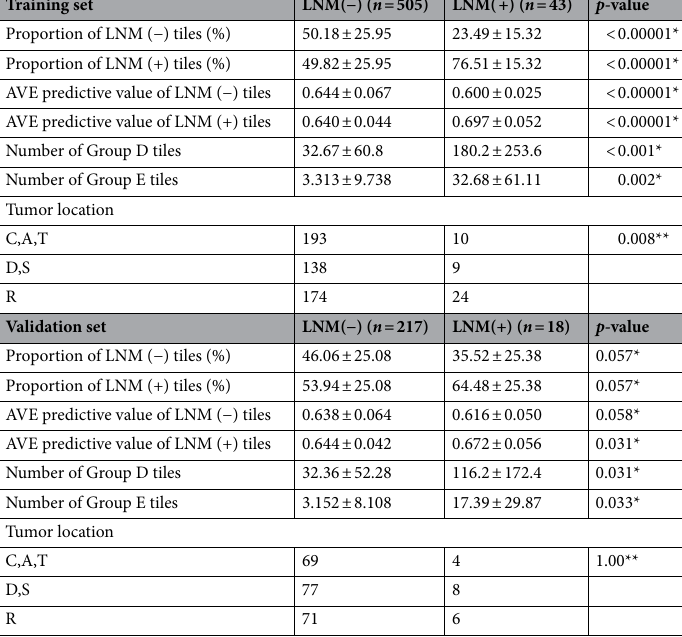
Table 1. Comparison of important parameters for random forests. Average ± standard deviation. LNM(−), lymph node metastasis negative; LNM(+), lymph node metastasis positive; AVE, average, C, cecum; A, ascending colon; T, transverse colon; D, descending colon; S, sigmoid colon; R, rectum. *Student t-test, ** non- rectum versus rectum, Fisher exact test.